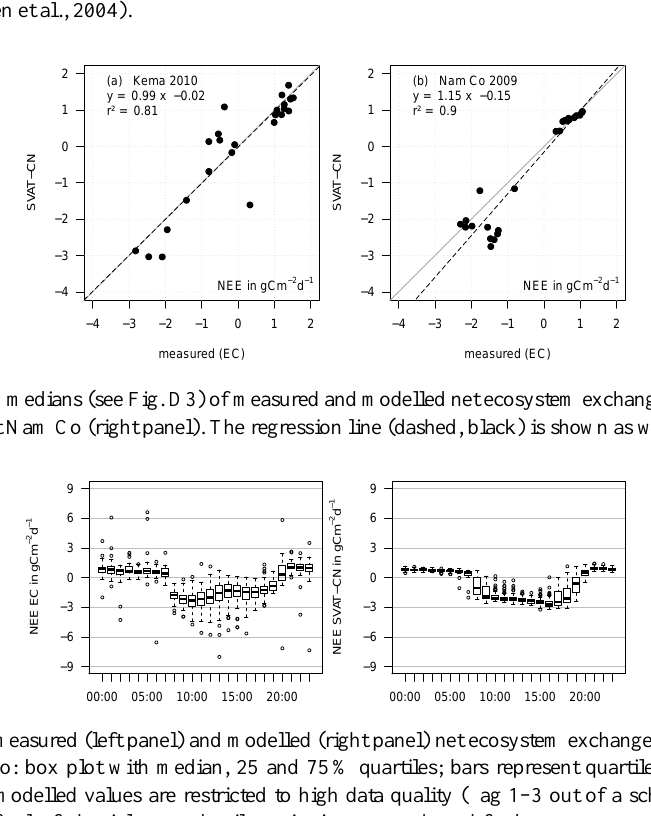
Figure B3. Mean diel course of measured (left panel) and modelled (tile approach according to the EC footprint: S RefEC , right panel) net ecosystem exchange (NEE) over 61 days of 2010 (3 June to 2 August) at Kema: box plot with median, 25% and 75% quartiles; bars represent quartiles ± 1.5 times interquartile range, dots are outliers. Measured and modelled values are restricted to high data quality (flag 1–3 out of a scheme ranging from 1 to 9, Foken et al., 2004).